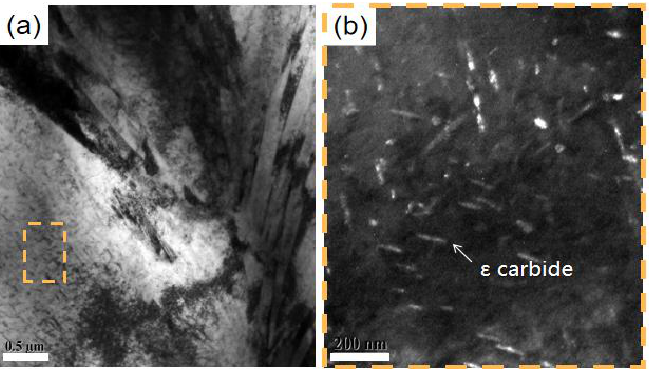
Figure 5. TEM image of NM500 of NM500/Q345 composite board at 900 °C + 200 °C: ( a ) high density dislocations in martensite; ( b ) acicular and rod-shaped precipitation in martensite